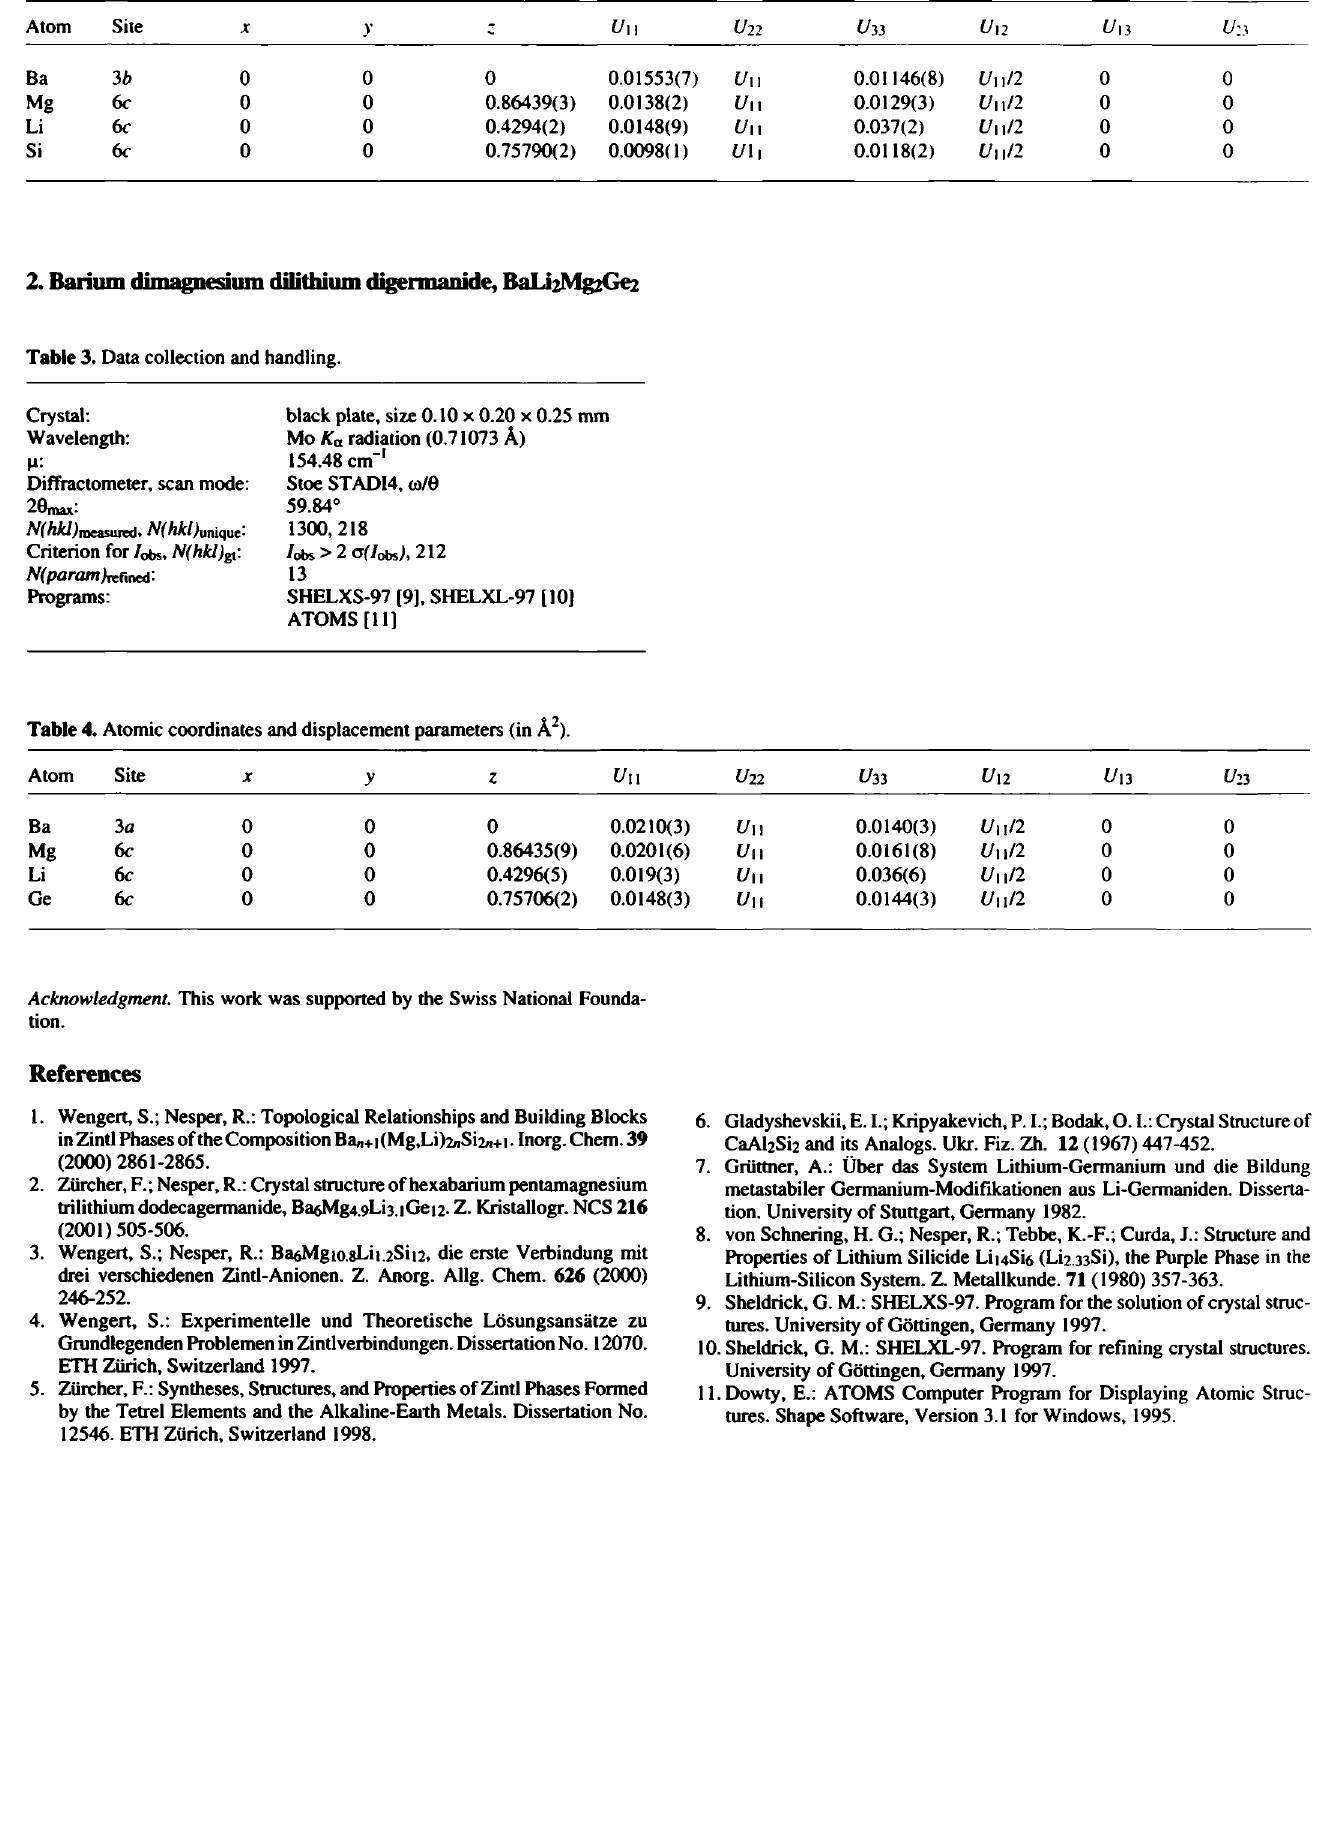
Table 3. Data collection and handling.